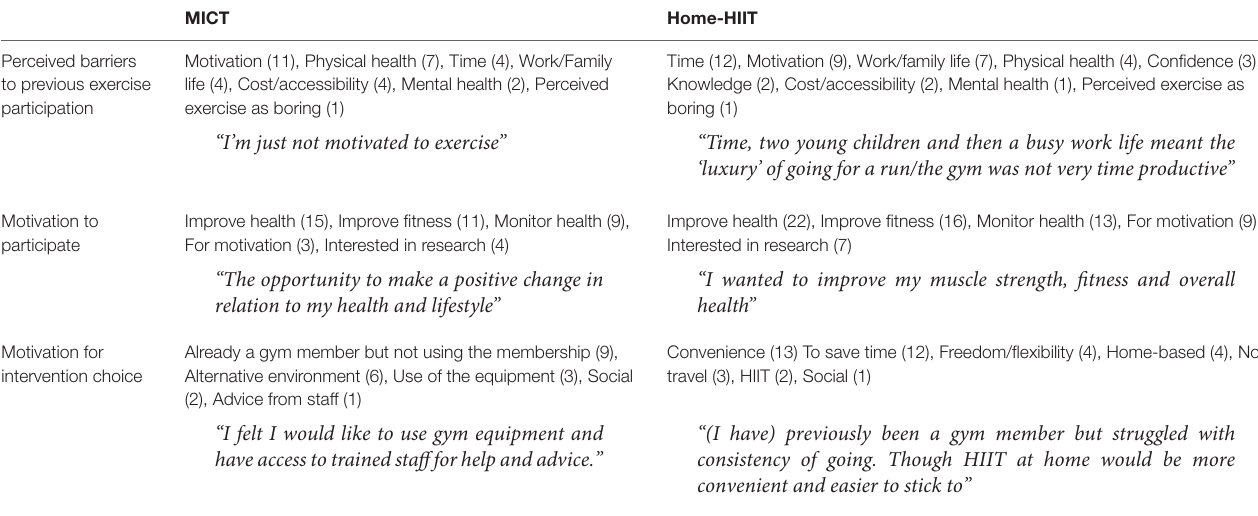
TABLE 7 | Perceived barriers to previous exercise participation, motivation behind participation and motivation for intervention choice. MICT Home-HIIT Perceived barriers to previous